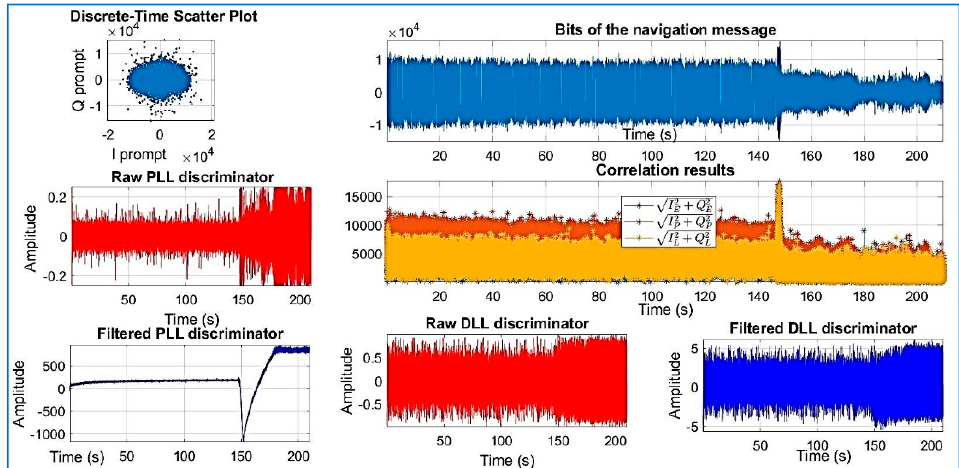
Figure 18. PRN 10, channel 01, Dataset 3.